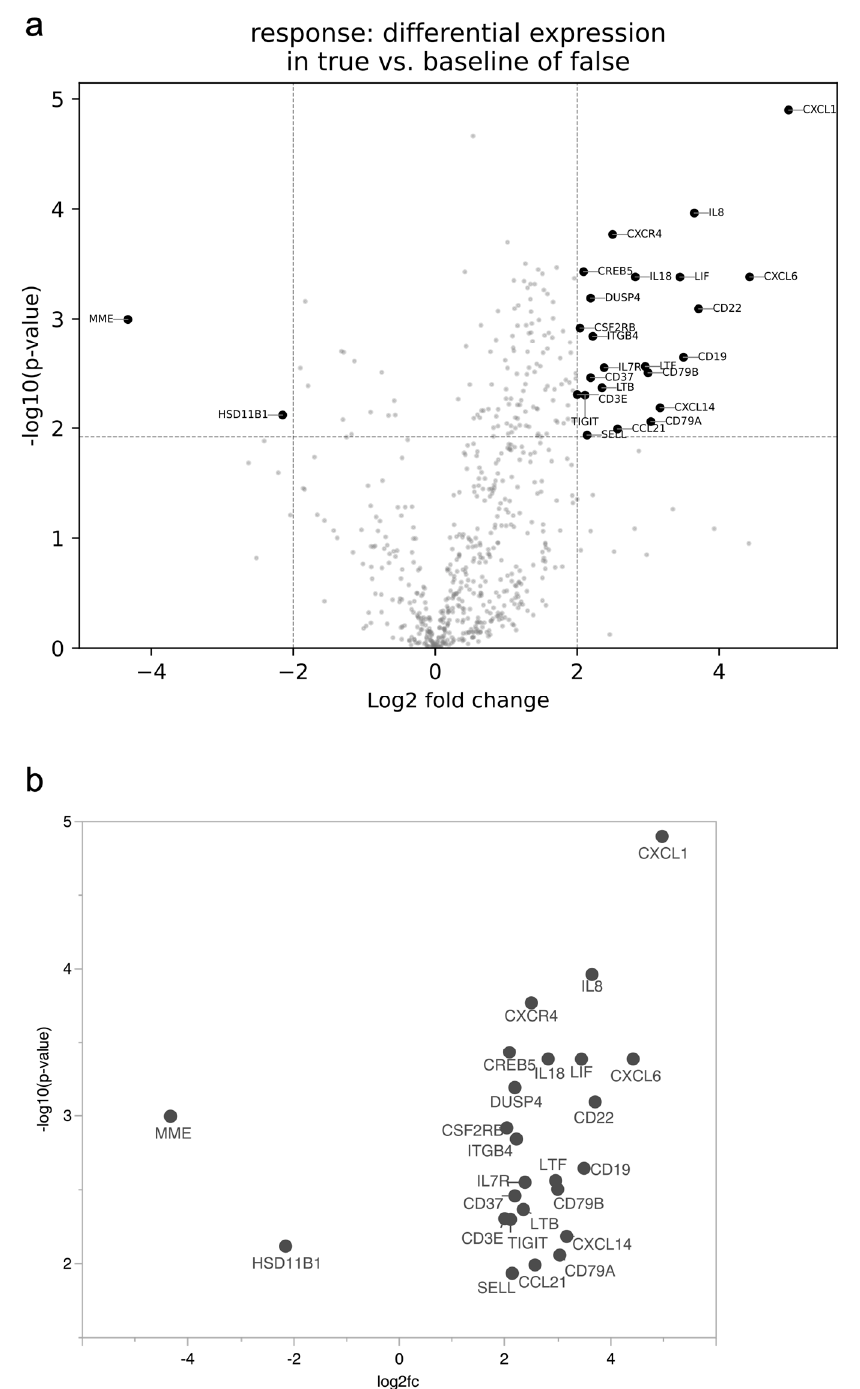
Figure 3. Differentially expressed genes between responders and non-responders to TACE. ( a ) Volcano plot of all differentially expressed genes or ( b ) only strong and significantly deregulated genes (log2fc ≤ − 2 or ≥ 2 and p -value < 0.05 with Benjamini–Hochberg correction). Volcano plot displaying each gene’s -log10( p -value) and log2 fold-change with the selected covariate. Statistically signifi- cant genes fall at the top of the plot above the horizontal line, and highly differentially expressed genes fall to either side. The horizontal line indicates BH- p < 0.05. Abbreviations: transarterial chemoembolization